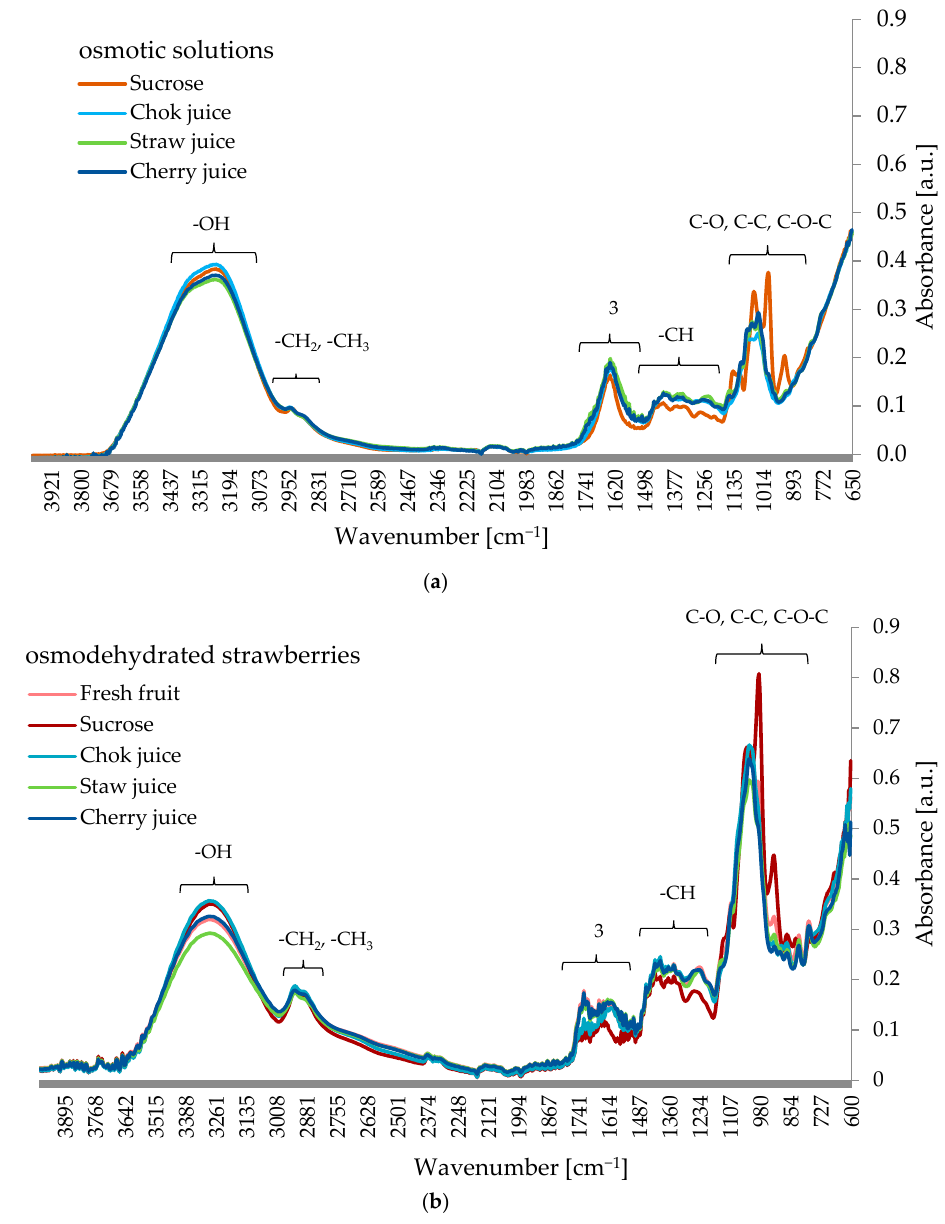
Figure 7. Effect of the type of osmotic agent (sucrose and fruit concentrates) on the antioxidant ac- tivity of osmodehydrated strawberries. Different letters (small letters are for antioxidant activity according to ABTS radical, capital letters are for antioxidant activity according to DPPH radical) above columns show the statistical difference ( p < 0.05).